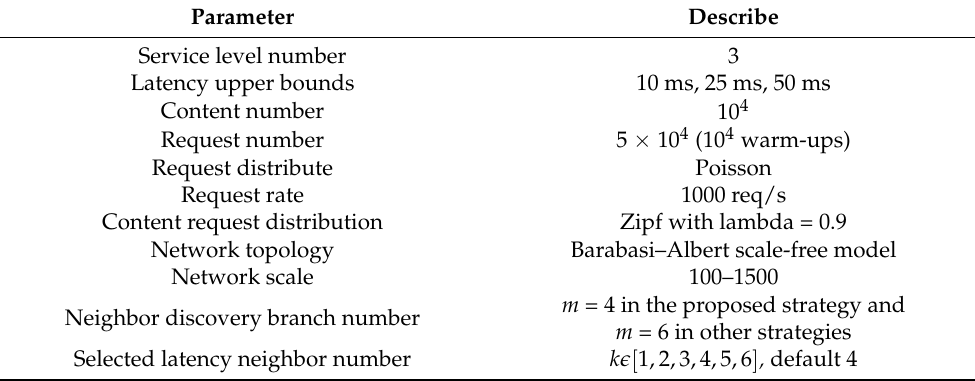
Table 2. Simulation